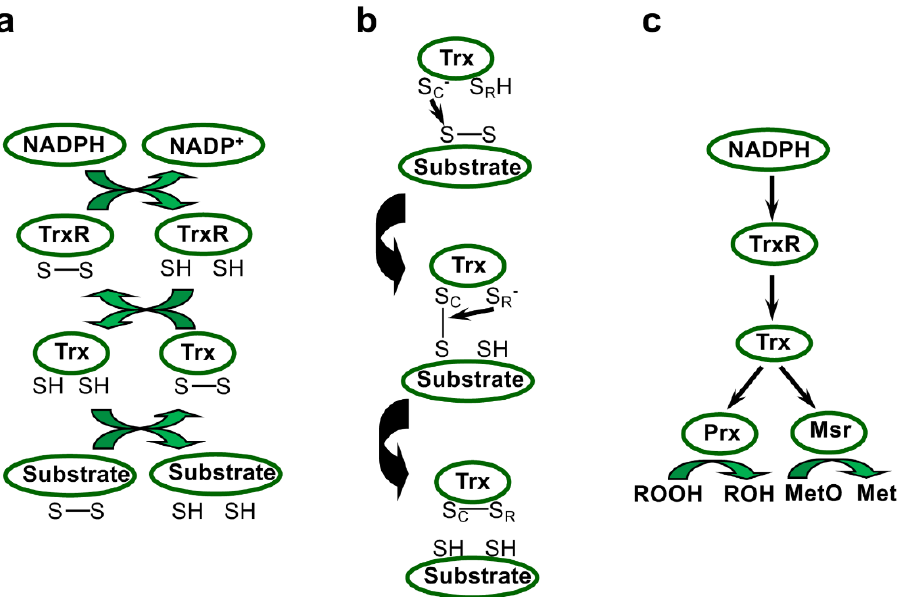
Figure 1. The Trx system. ( a ) NADPH-dependent electron transfer via Trx. ( b ) Catalytic mechanism of substrate reduction by Trx. ( c ) Trx thiol reductase substrates involved in the maintenance of cell redox homeostasis. TrxR, thioredoxin reductase; Trx, thioredoxin; Prx, peroxiredoxin; Msr, methionine sulfoxide reductase; S C H, catalytic cysteine thiol; S R H, resolving cysteine thiol; MetO, methionine sulfoxide.